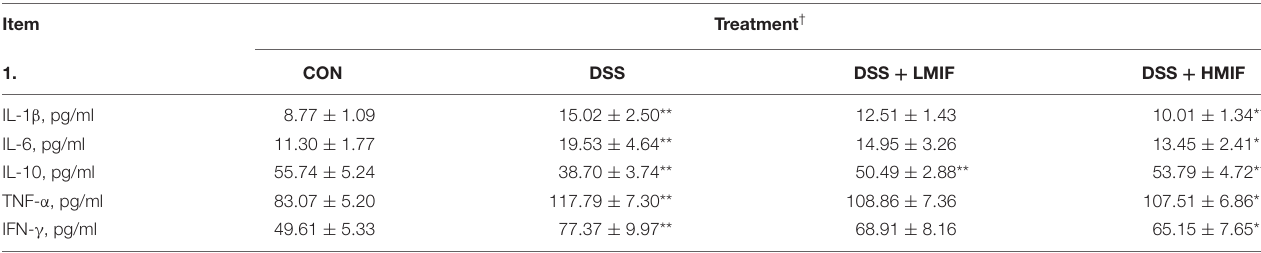
TABLE 4 | Effects of Morchella importuna flavones on the colonic cytokine concentrations in DSS-challenged